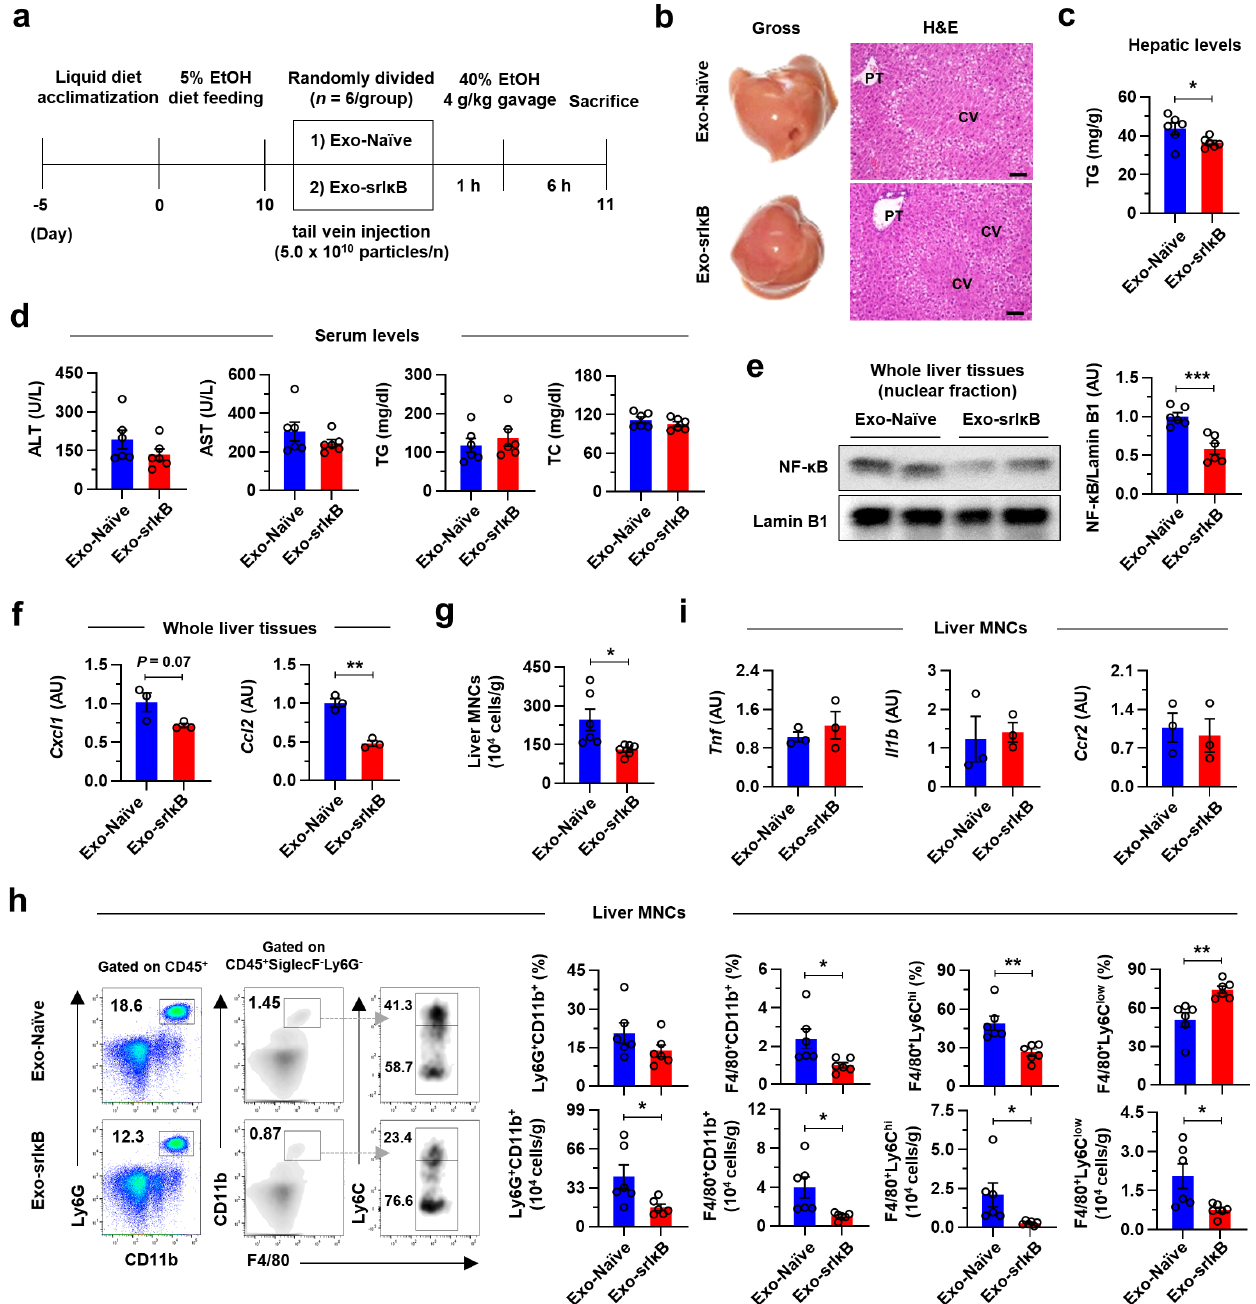
Figure 4. A single high dose of Exo-srI κ B ameliorates AFL but not ALI in mice. ( a – h ) Wild-type (WT) male mice were fed ethanol (EtOH) for 10 days and randomly divided into Exo-Naïve or Exo-srI κ B groups ( n = 6 per group). A single high dose (5.0 × 10 10 particles per mouse) of exosomes were intravenously injected. After 1 h, mice were given acute EtOH binge drinking (4 g kg − 1 of 40% EtOH gavage) and sacrificed after 6 h. ( a ) Schematic diagram of experiments. ( b ) Representative gross finding and H&E staining of liver tissues. Central vein (CV) and portal triad (PT). Scale bars, 50 µm. ( c ) Hepatic triglyceride (TG) levels were measured. ( d ) Serum levels of alanine aminotransferase (ALT), aspartate aminotransferase (AST), TG, and total cholesterol (TC) were measured. ( e ) Repre- sentative Western blot analyses of hepatic nuclear fraction (two blots/group) and densitometry anal- ysis ( n = 6 per group). ( f ) qRT-PCR analyses of whole liver tissues ( n = 3 per group). ( g ) The number of mononuclear cells (MNCs) per gram of liver tissue. ( h ) Flow cytometry analyses of liver MNCs with representative panels and bar graphs indicating frequencies or absolute numbers of the indi- cated population. ( i ) qRT-PCR analyses of liver MNCs ( n = 3 per group). Data are presented as mean ± SEM. * p < 0.05, ** p < 0.01, *** p < 0.001. Data were analyzed by a two-tailed Student’s t -test.